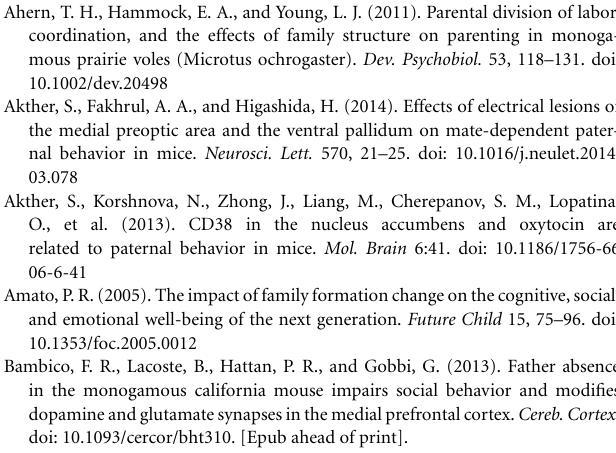
FIGURE 5 | Paternal retrieval test in ICR mice isolated prior parturition from the mating pair and then united with pups only. A paired couple was kept in a rearing cage from mating to 1 day before parturition (A) . The male was kept in the old cage (B) before meeting the pups and kept until P2 (D) . The female was kept in a new cage (C) , delivered her pups, and remained until postnatal day 2 (E) . The pups were transferred twice for 3h (total 6h) a day (G) from the dam’s (new) cage (H) during P3 to P5. During